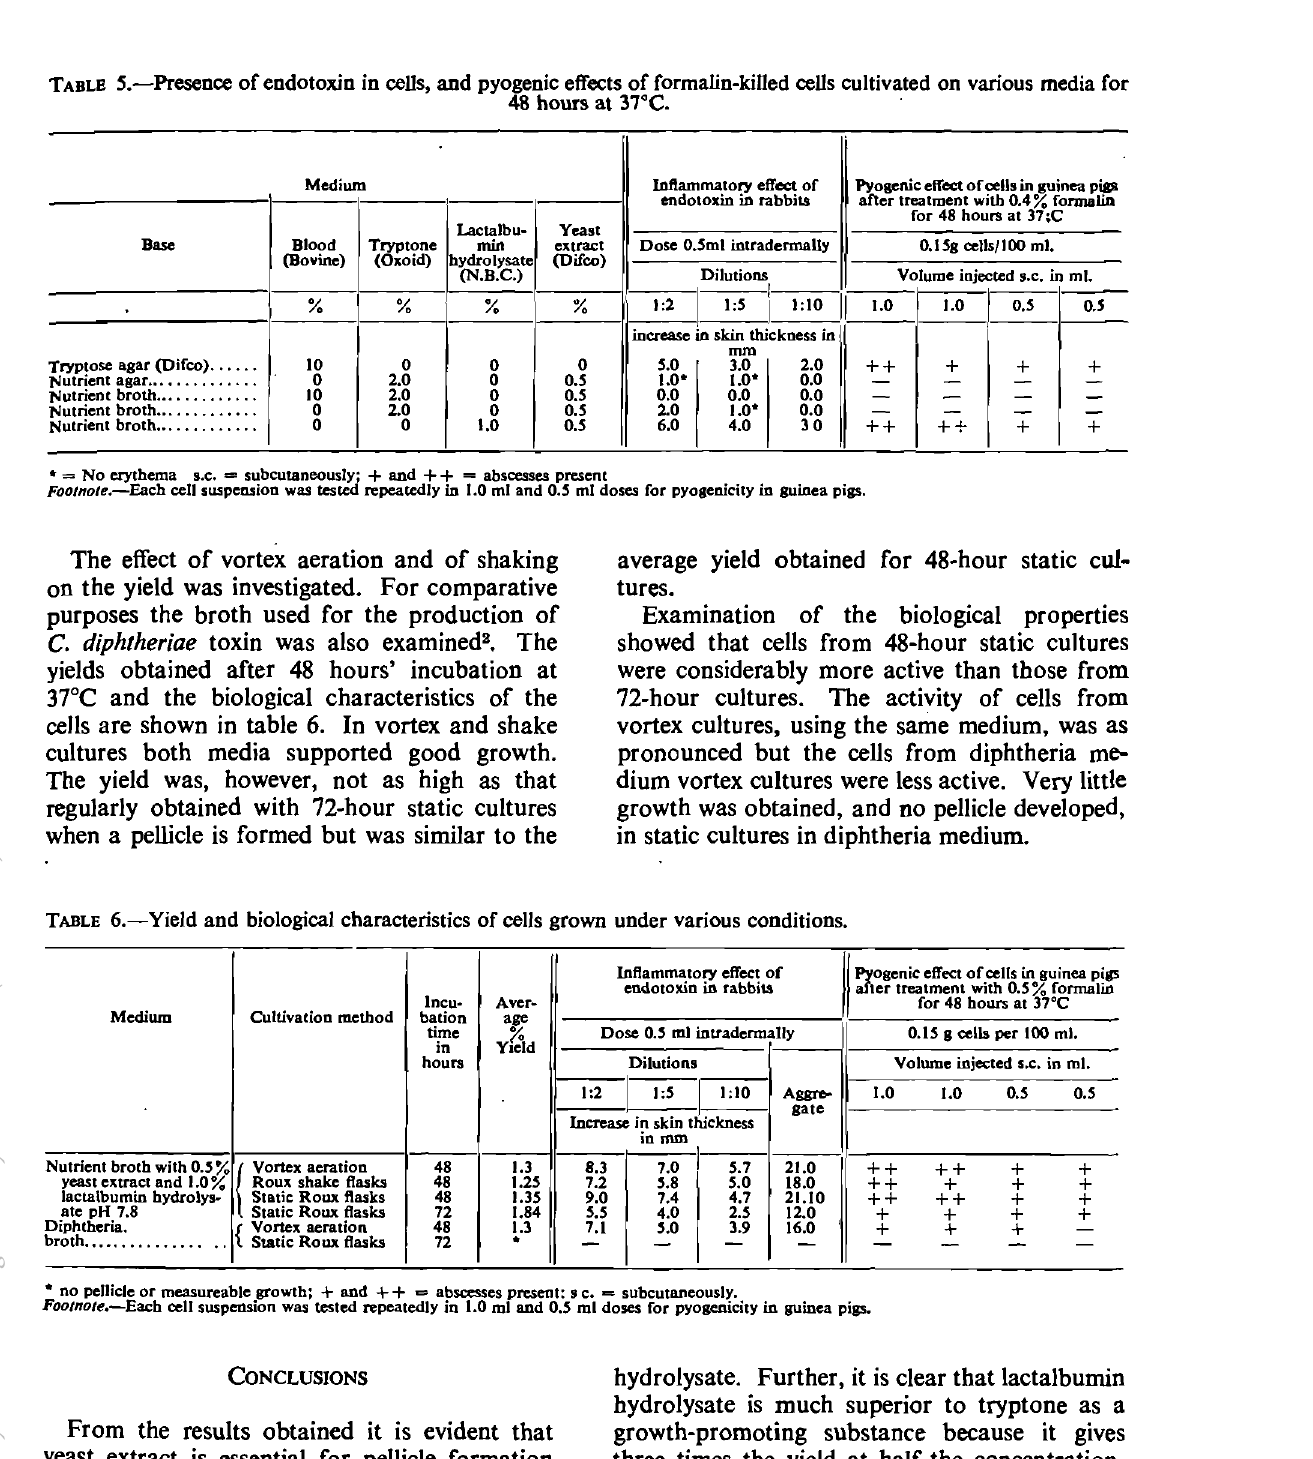
TABLE S.-Presence of endotoxin in cells, and pyogenic effects of formalin-killed cells cultivated on various media for 48 hours at 37°C.